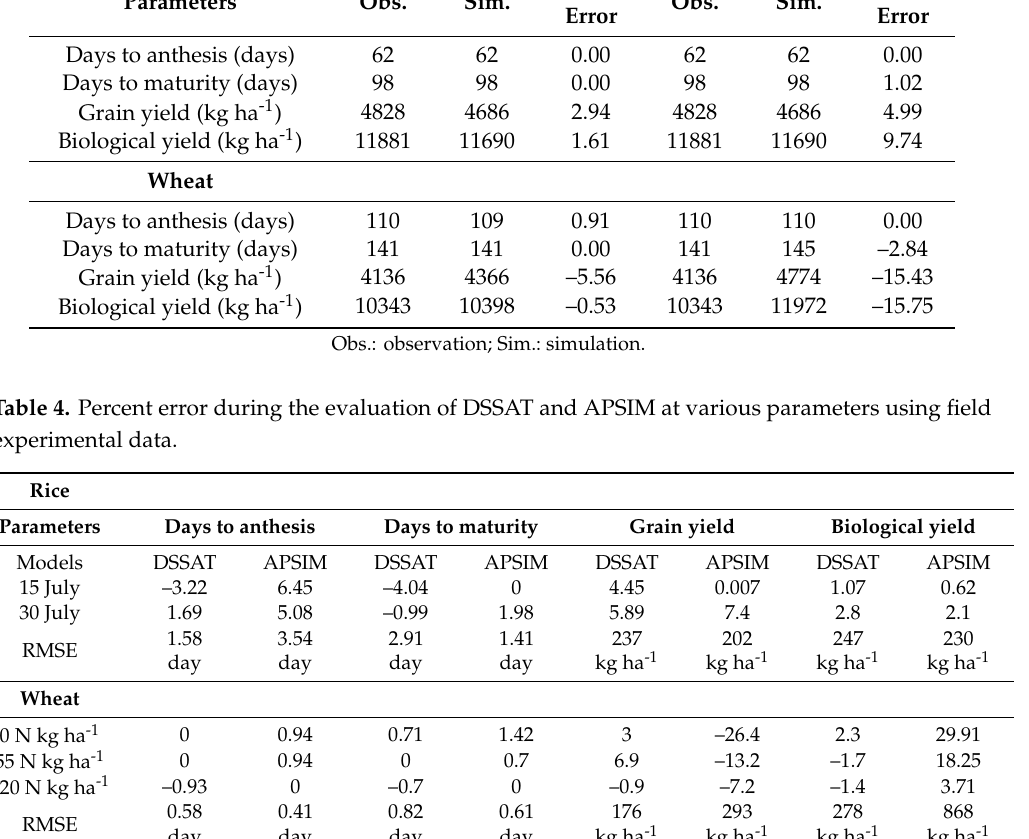
Table 3. Calibration of DSSAT and APSIM for rice-wheat at various parameters using field. Rice DSSAT APSIM Parameters Obs. Sim.